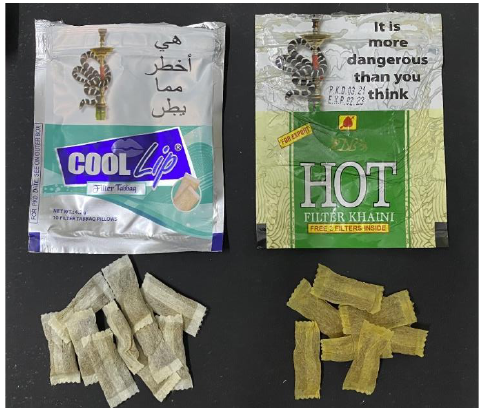
Figure 4. The smokeless tobacco (tabbaq and khaini) used in this study. The samples in the test groups were immersed in the smokeless tobacco solutions for 3 h at 37 °C (with the polished surface facing up). They were later washed in running water and immersed in an artificial salivary substitute solution at 37 °C for the rest of the day [36,37]. The control group specimens were immersed in artificial saliva for 24 h at 37 °C (Figure 5). This cycle was repeated for 90 days, following which the final color and surface-roughness measurements were recorded (Figure 6).